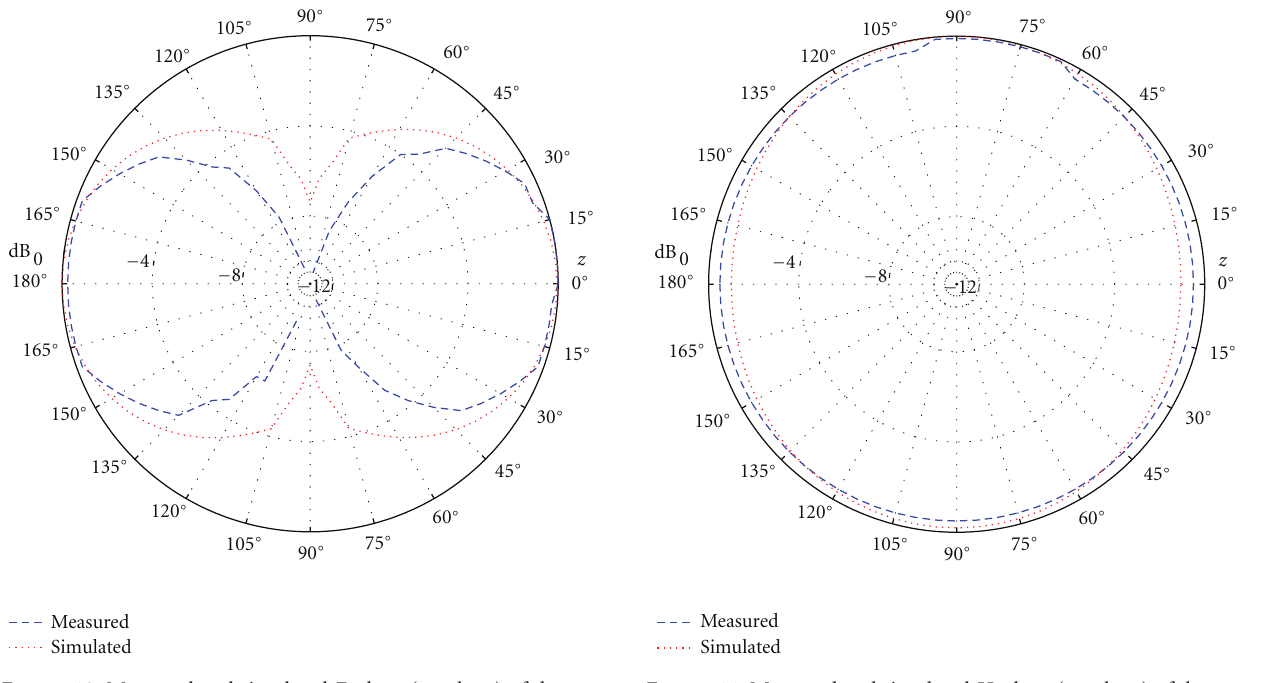
Figure 13: Measured and simulated E -plane ( yz -plane) of the tags radiation pattern, using normalized gain (dB) values, at 860 MHz.